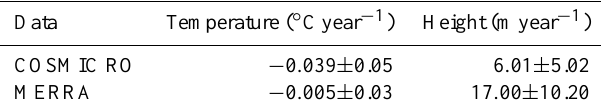
Table 3. Trends in tropopause temperatures ( ◦ Cyear − 1 ) and heights (myear − 1 ) based on the area-averaged time series anomalies de- rived from COSMIC RO and MERRA. Data span between August 2006 and December 2013. Uncertainties in trend estimates are re- ported at 95% confidence